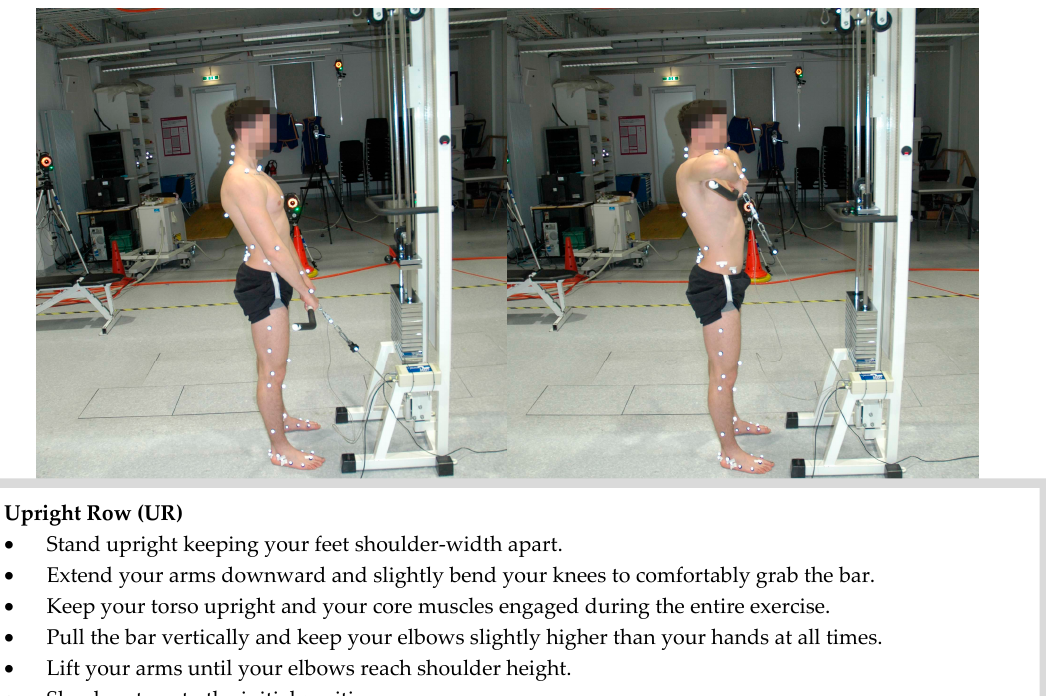
Figure A4. Experimental setup and execution of the upright row . The subject with a complete IfB marker set is shown.